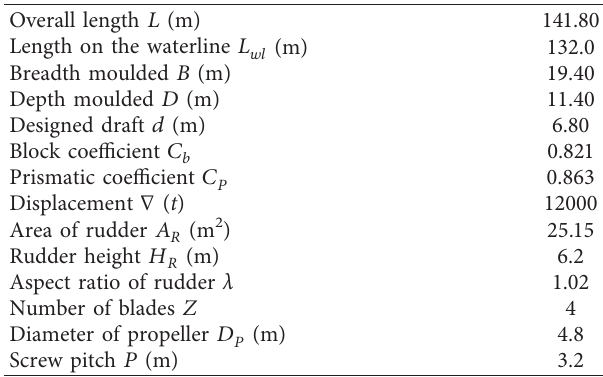
Table 1: Target ship master scale and main parameters of the rudder and pulp.